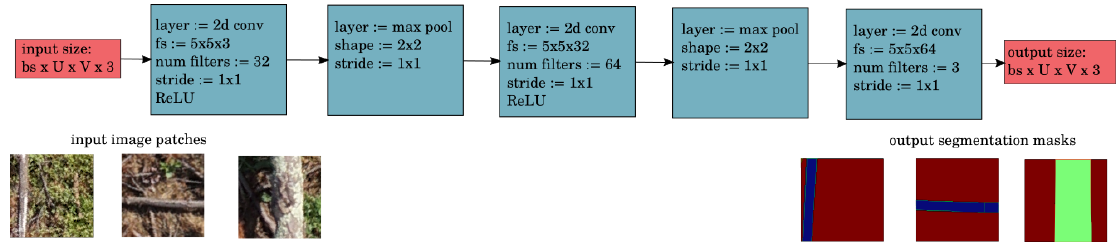
Figure 5. Flowchart illustrating the segmentation network architecture. U and V represent the number of rows and columns respectively of the input image patch, and fs is the filter size of the convolving kernel. Some example input image patches and their corresponding segmentation masks predicted by the network are shown (classes: green-CWD, blue-FWD,